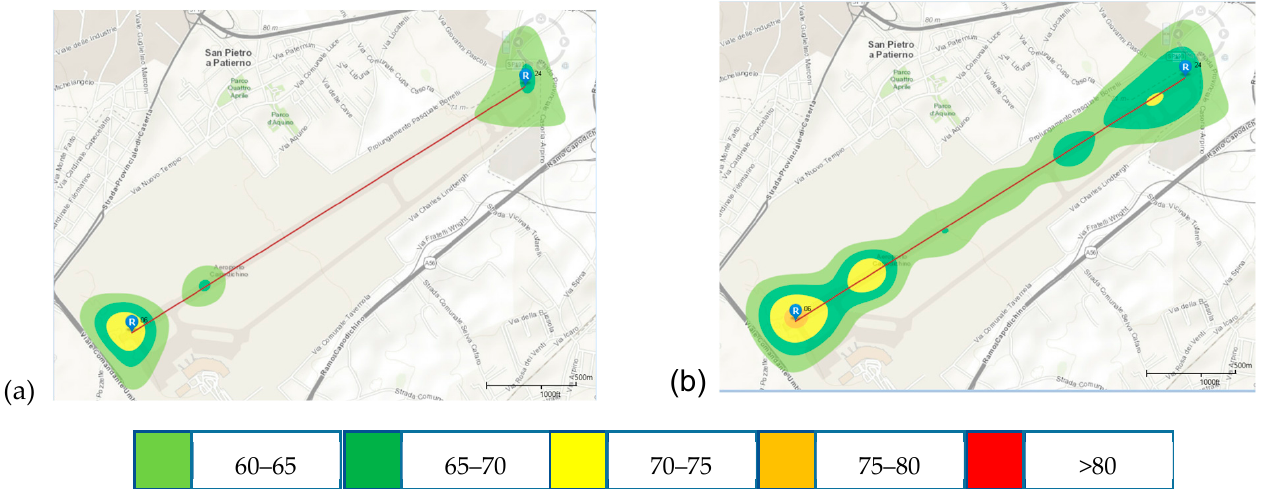
Figure 43. L DEN (dB-A) of the assessed traffic scenario for the conventional ( a ) and hybrid ( b ) configurations.